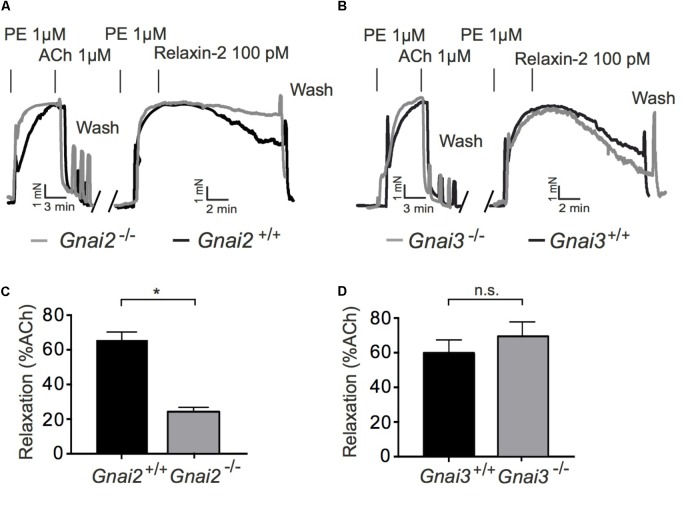
Vasorelaxant effects of relaxin-2 in Gαi2 deficient (Gnai2-/-), Gαi3 deficient (Gnai3-/-), and control arteries. (A,B) Original representative recordings. (C) Summary of data. Gαi2 deficient arteries; n = 9 out of five mice. Control; n = 9 out of four mice. (D) Summary of data. Gαi3 deficient arteries; n = 6 out of five mice. Control arteries; n = 7 out of four mice. ∗P < 0.05 using unpaired t-test.; n.s., not significant.